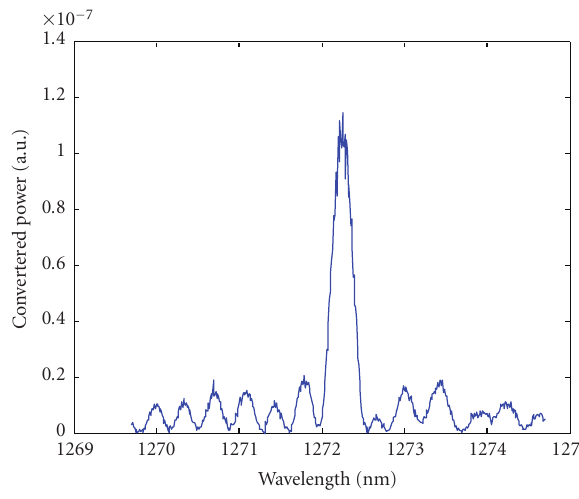
Figure 7: Measured transmission power against wavelength for Ti:PPLN ˇ Solc-type wavelength filter with 16.7 μ m-period: center wavelength (1272.3 nm), FWHM bandwidth ( ∼ 0.24